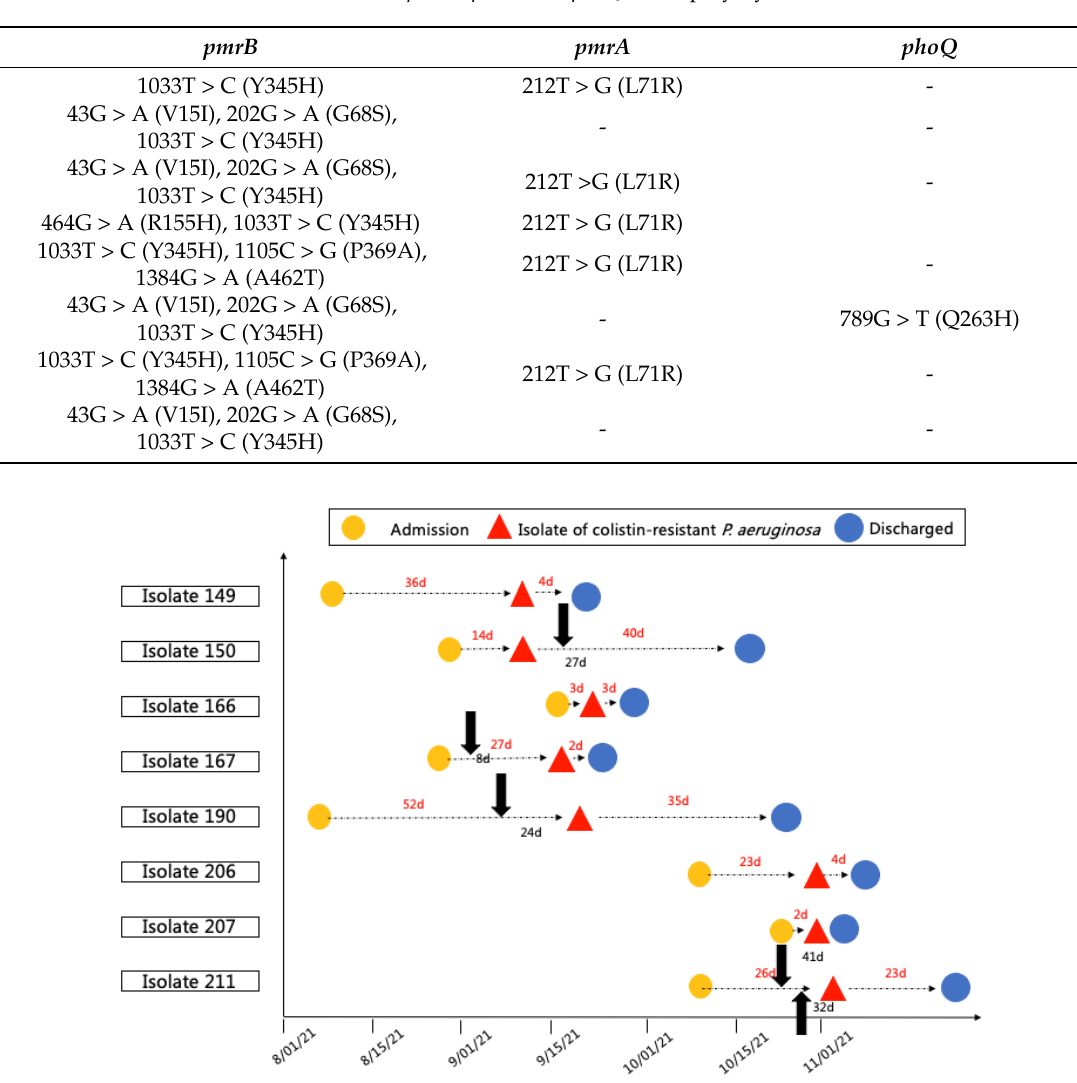
Table 3. Genetic variations in pmrA , pmrB and phoQ of the polymyxin-resistant isolates.